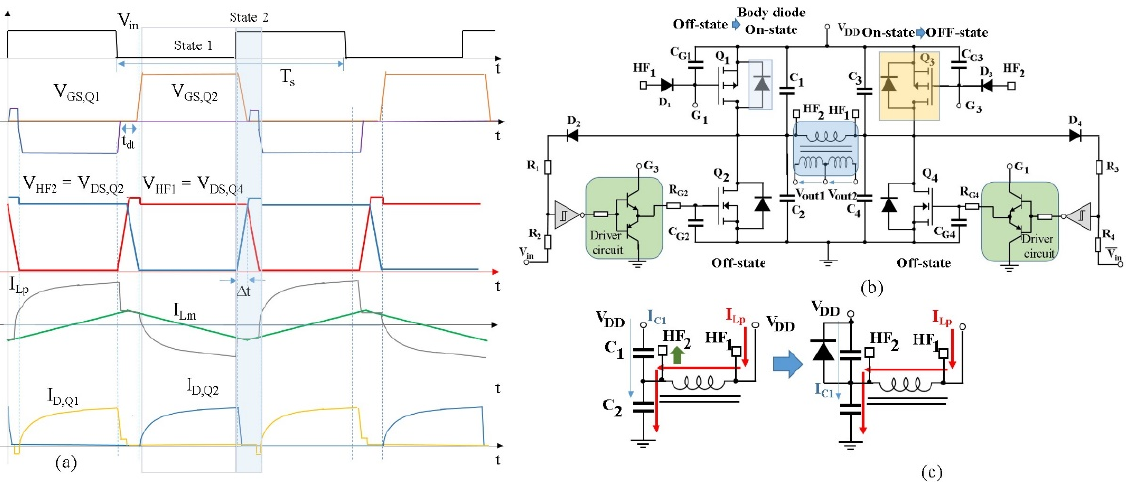
Figure 8. ( a ) Qualitative switching waveforms description at second phase of the operative condition (State 2). ( b ) Switching conditions of the MOSFETs. ( c ) Primary side of the HF transformer and capacitors’ interactions.